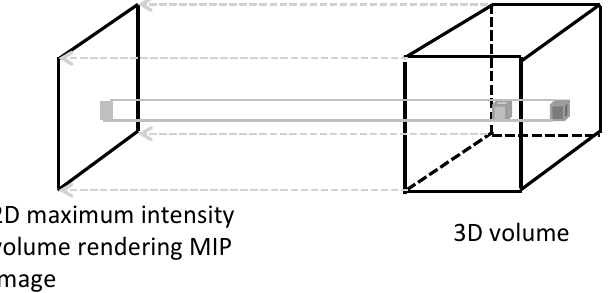
Figure 2. Illustration of volume rendering with maximum intensity projection (MIP). During this process, a series of parallel rays are traced from the 3D volume to the 2D image. The MIP image is created by displaying the voxel in a particular ray that has the highest brightness level (or Hounsfield Unit in CT). Note that the 3D volume contains a dark gray voxel and a light gray voxel, yet on the 2D image only a light gray pixel is shown.